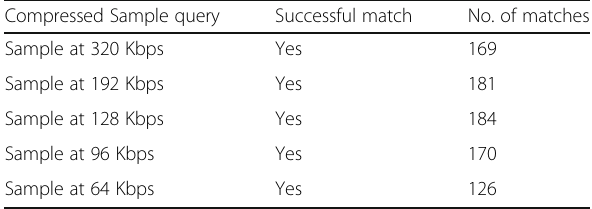
Table 1 Robustness test using compression (Shazam) Table 2 Robustness test using compression (ORB)